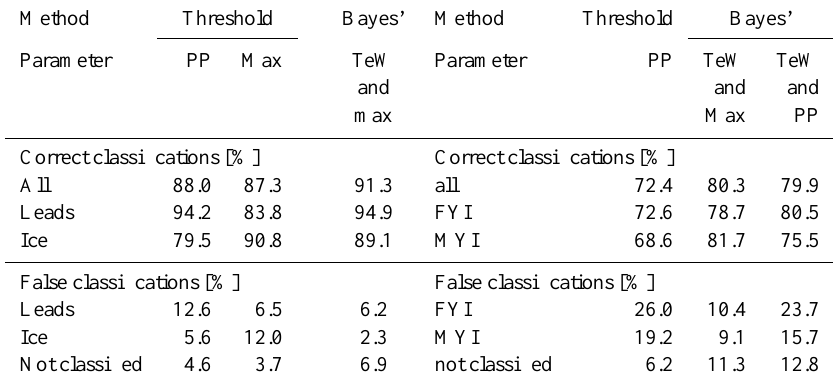
Table 3. Results for the two different classification methods: rule-based threshold and Bayesian classifier. The overall classification rates, the probabilities of correct and false detection for ice and leads (left) and for first-year ice and multi-year ice (right) are presented. The classification rates are defined in Eqs. (2) and (3). The used parameters are the pulse peakiness (PP), the power maximum (Max) and the trailing edge width (TeW). Method Threshold Bayes’ Method Threshold